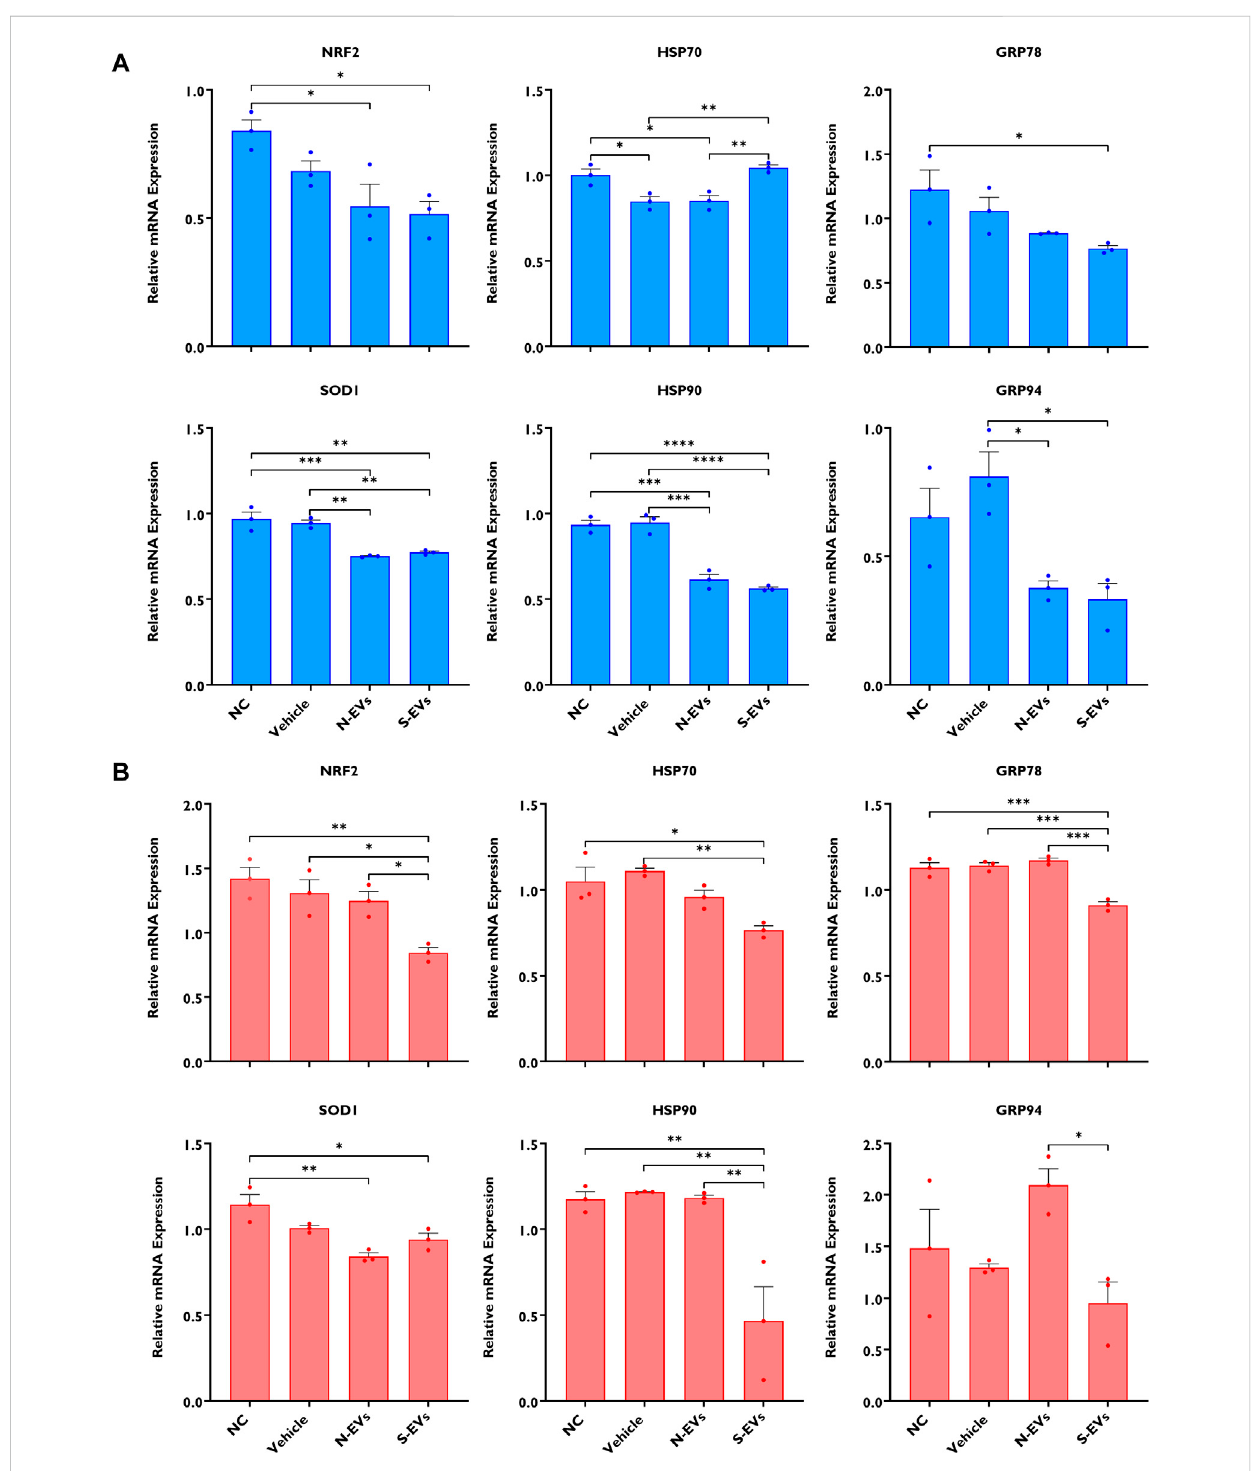
FIGURE 4 The impact of GC-EV supplementation on transcript levels of stress-associated genes in oocytes following maturation at 38.5 ° C (blue) and 41 ° C (red).Theexpressionofstress-associatedgenesweresigni fi cantlydiminishedinoocytessupplementedwithN-EVsandculturedat38.5 ° C (A) ,andsimilar decreases in gene expression were visualized in oocytes supplemented with S-EVs and exposed to HS (B) . Results are from a total of three pools of 50oocytesperpoolforeachtreatment.Datarepresentthemean±SEMandthedifferencesbetweenmeanswereanalyzedusingOne-wayANOVA followed by Tukey ’ s Multiple Comparisons Test. (* p < 0.05), (** p < 0.01), (*** p < 0.001), (**** p <